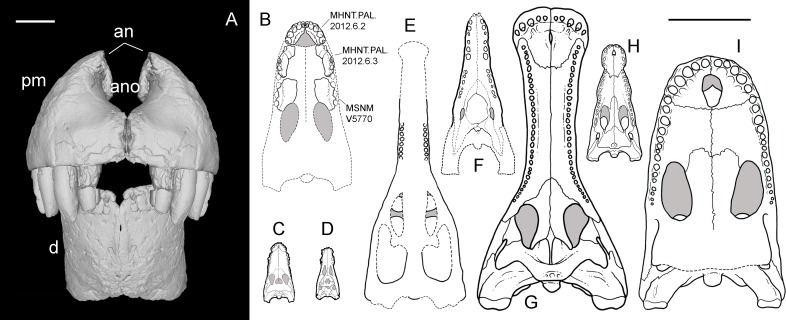
Snout reconstruction and size comparisons.3-D reconstruction of the snout of R. sakalavae in rostral view (A), including the left dentary (MHNT.PAL.2012.0.6.1), the right premaxilla (MHNT.PAL.2012.0.6.2), and their counterlateral copies obtained from CT data; composite reconstruction of the skull of R. sakalavae in palatal view ((B) the specimens are indicated in the figure), and size comparisons with the notosuchians Gasparinisuchus peirosauroides
Martinelli et al., 2012 (C) and Baurusuchus salgadoensis
Carvalho, De Arruda Campos & Nobre, 2005 (D), the giant thalattosuchian Machimosaurus rex
Fanti et al., 2016 (E), the giant sebecid Barinasuchus arveloi
Paolillo & Linares, 2007 (F), the largest extant crocodilian Crocodylus porosus
Schneider, 1801 (H), and two of the biggest neosuchians, Sarcosuchus imperator
De Broin & Taquet, 1966 (G), and Purussaurus brasiliensis
Barbosa-Rodrigues, 1892 (I). Grey areas indicate skull roof areas visible through the palatal fenestrae. Scale bar = 3 cm (A) and 50 cm (B–I). C–I redrawn respectively from: Martinelli et al. (2012), Carvalho, De Arruda Campos & Nobre (2005), Fanti et al. (2016), Paolillo & Linares (2007), Sereno et al. (2001), Grigg & Gans (1993), and Aureliano et al. (2015).